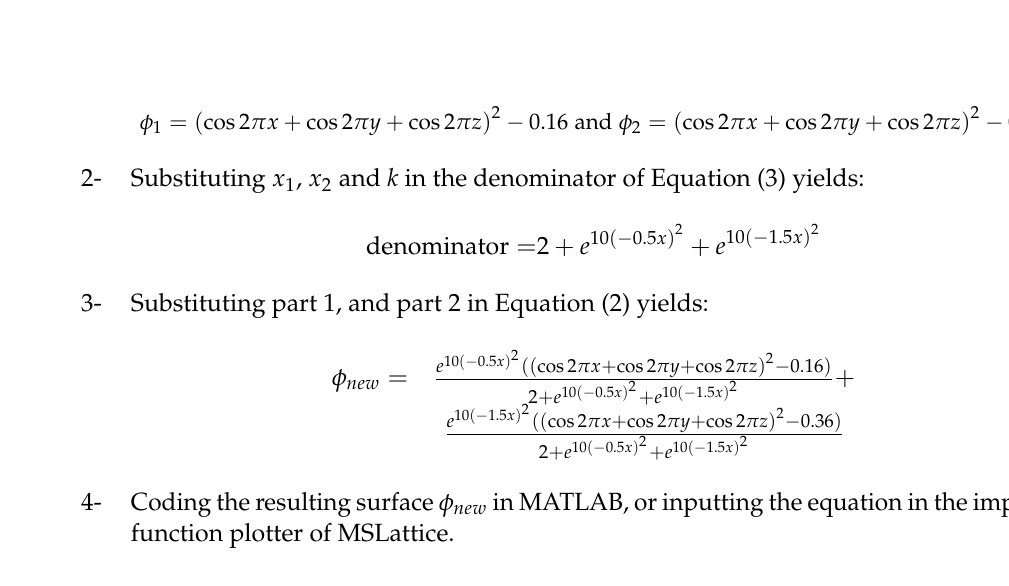
3- Substituting part 1, and part 2 in Equation (2) yields: